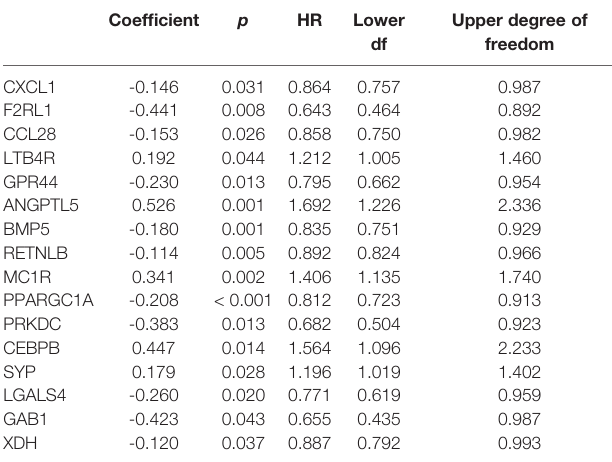
TABLE 1 | General characteristics of colorectal cancer ‐ speci fi c immune ‐ related genes. Coef fi